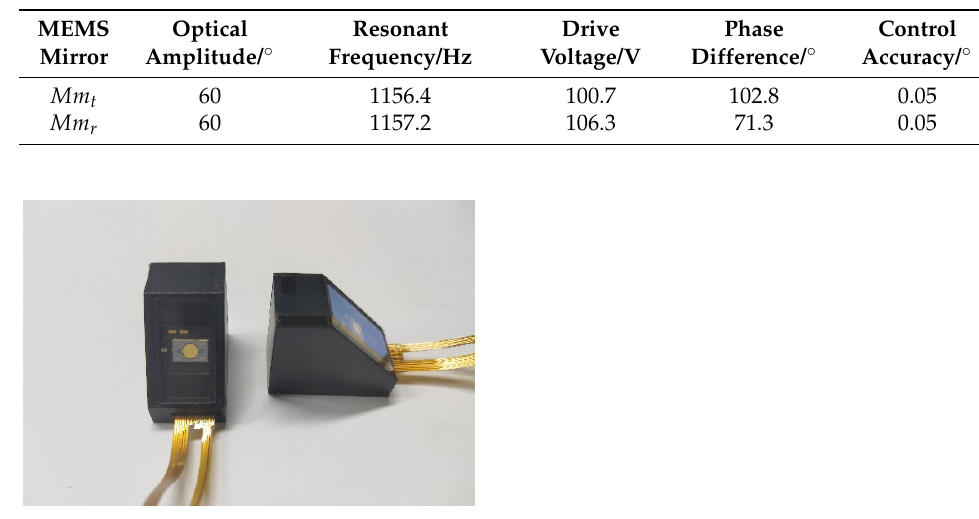
Figure 5. MEMS mirror modules.